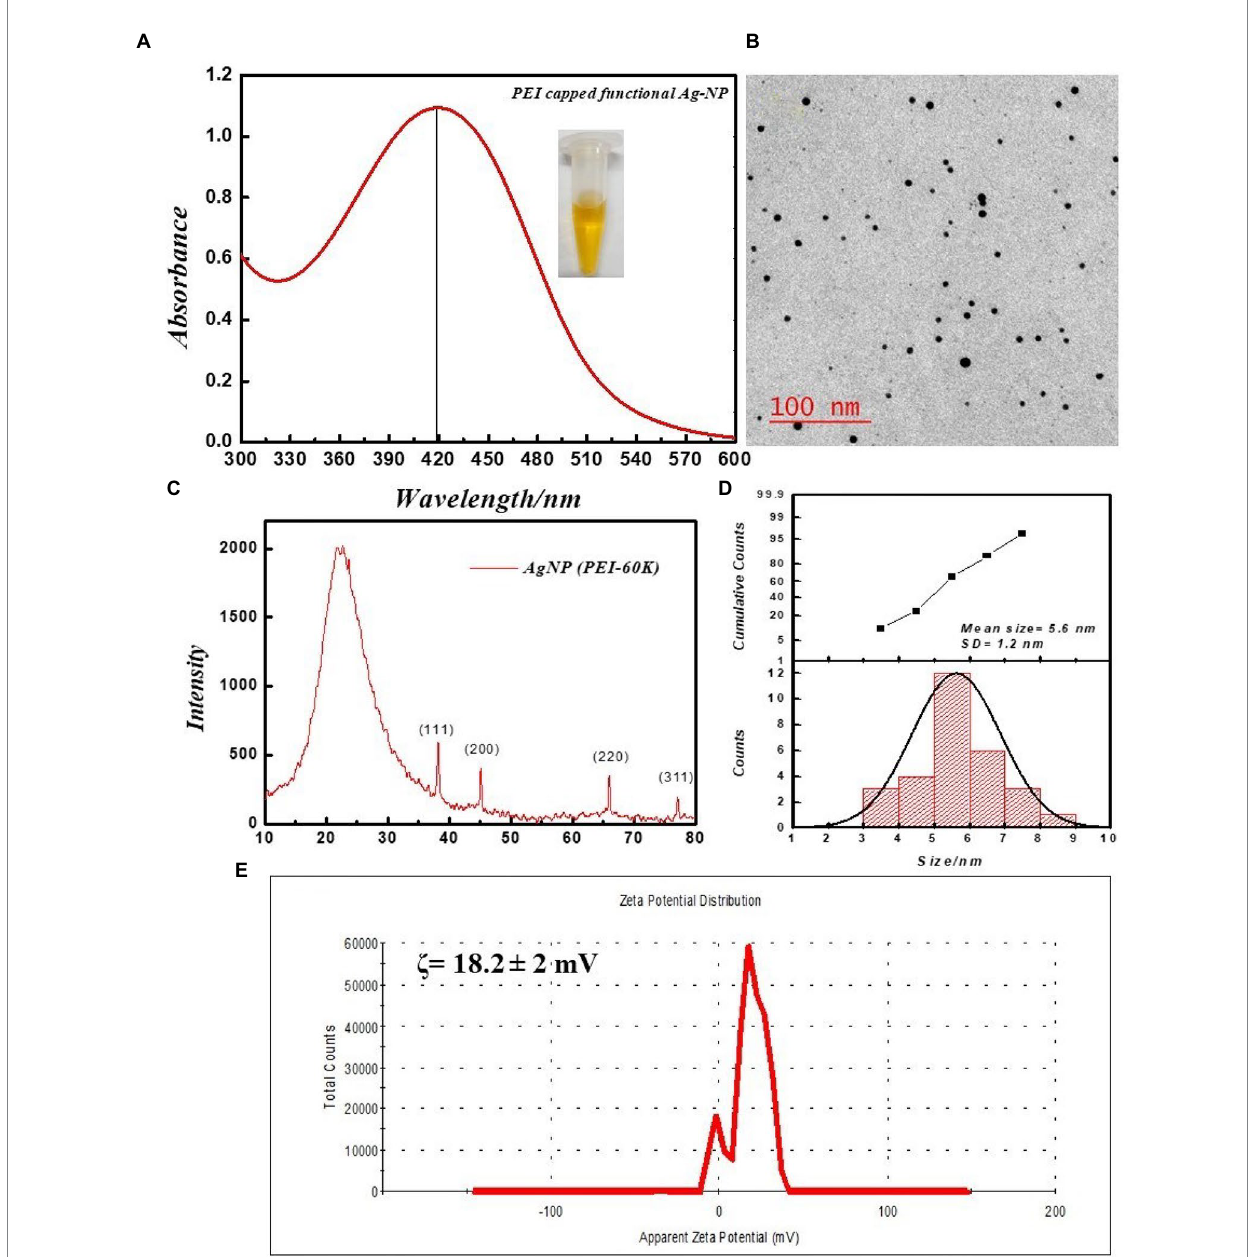
FIGURE 1 Physical characterization of PEI-f-Ag-NPs. (A) UV–VIS spectra: inset dispersed in water, (B) respective TEM image, (C) XRD diffractogram, (D) size distribution histogram, and (E) Zeta potential